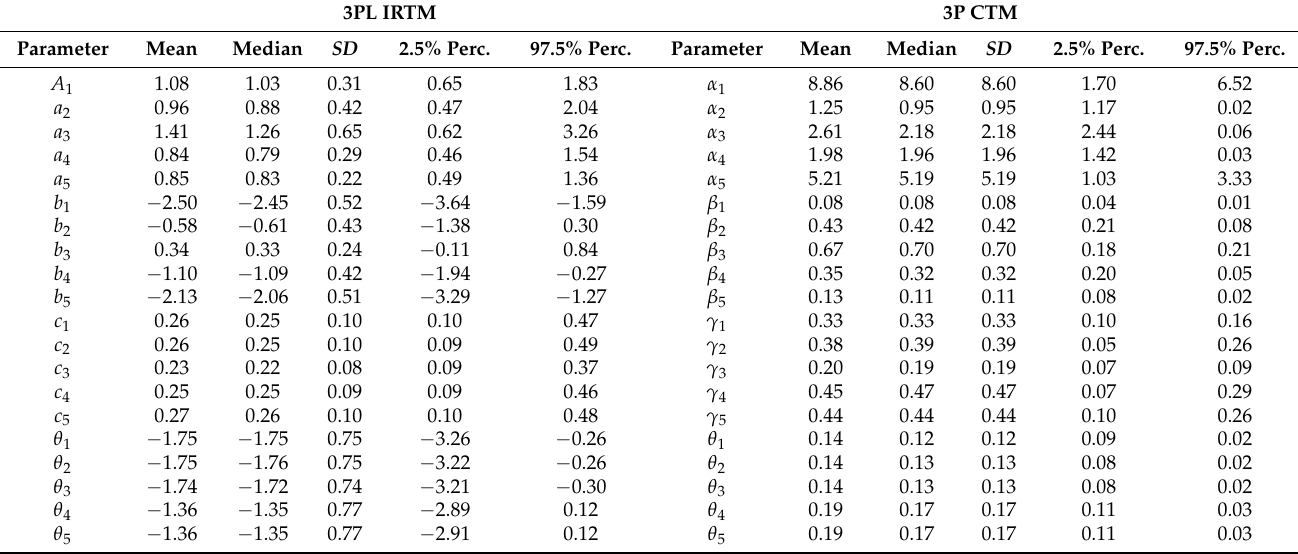
Table 5. LSAT Data Marginal Density Summary Statistics.